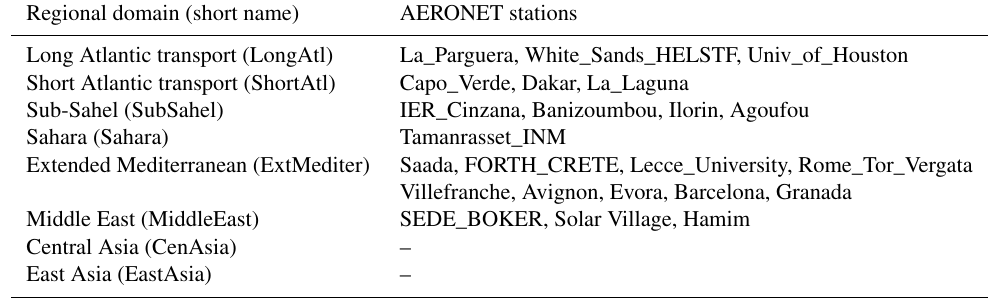
Table 2. Regional domains and respective groups of AERONET stations used for validation purposes.